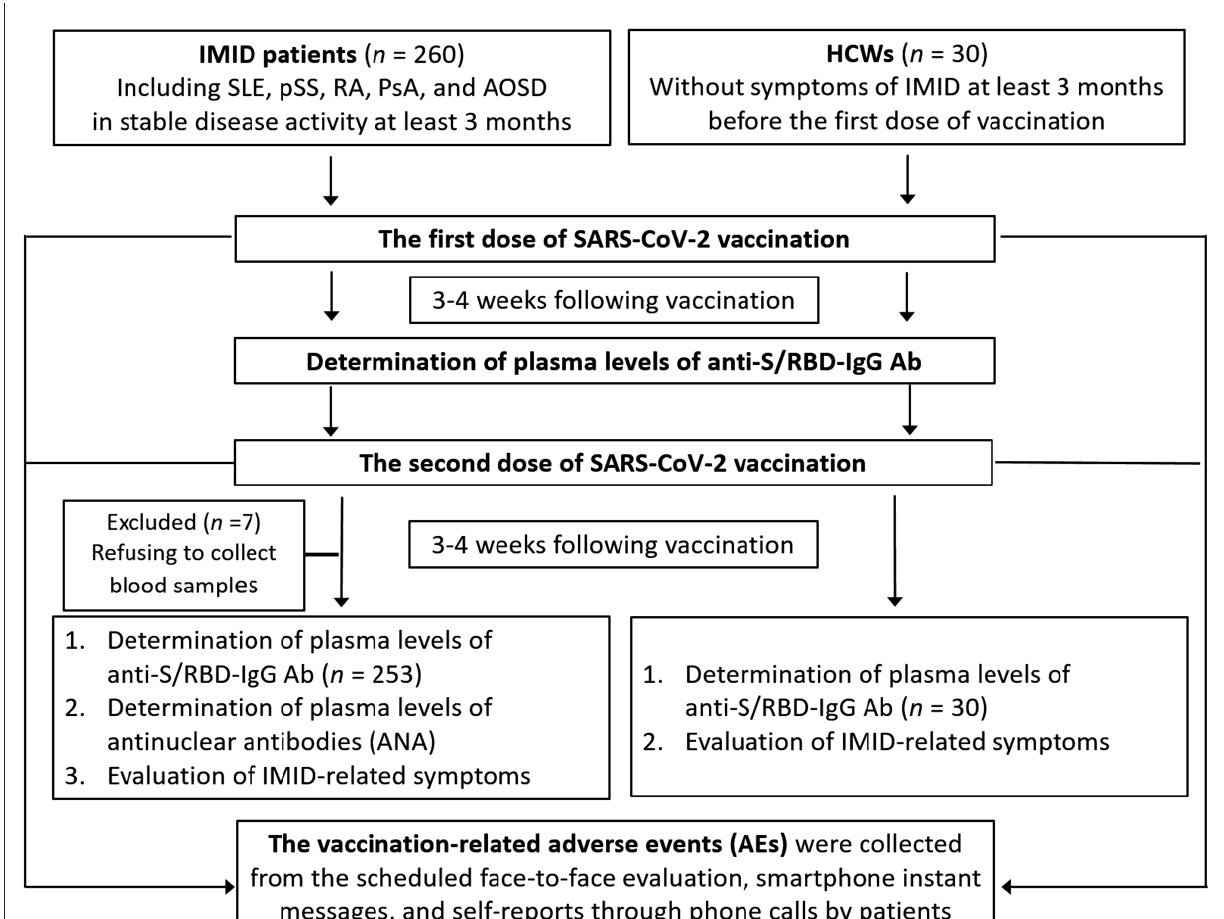
Figure 1. Study design workflow. IMID: immune-mediated inflammatory diseases; SLE: systemic lupus erythematosus; pSS: primary Sjögren’s syndrome; RA: rheumatoid arthritis; PsA: psoriatic arthritis; AOSD: adult-onset Still’s disease; HCWs: health- care workers; Anti-S/RBD-IgG Ab: IgG antibody against SARS-CoV-2 specific for the receptor-binding domain (RBD) of the spike-1 (S1) protein.